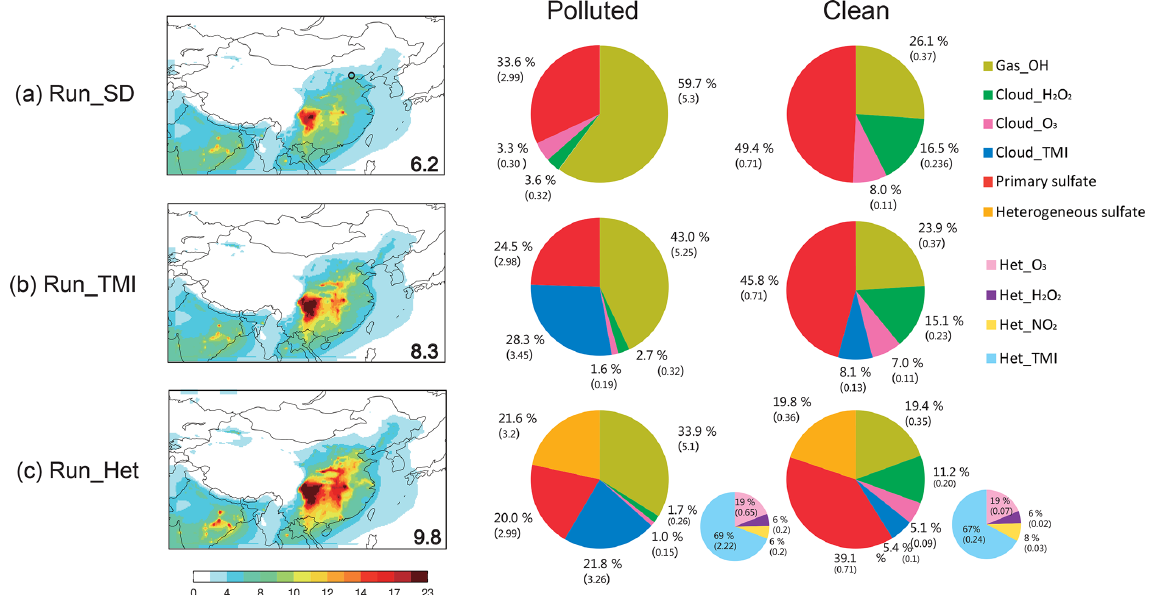
Figure 3. Model-simulated sulfate aerosol concentrations (µgm − 3 ) above the ground for (a) Run_Std, (b) Run_TMI, and (c) Run_Het. Panels on the left show the spatial distributions with the numbers in the inset representing simulated mean sulfate concentrations in Beijing (black circle in a ) during the entire measurement period. The middle and right columns show the percent contributions of different sulfate formation pathways to sulfate aerosol concentration in Beijing as calculated by the different model runs during polluted (HPP) and clean (CP) periods, respectively. The smaller pie charts in (c) show the relative contributions of the four heterogeneous sulfate formation pathways implemented in the model. Numbers are percentage contributions (%) and the absolute sulfate concentrations (µgm − 3 ) are in